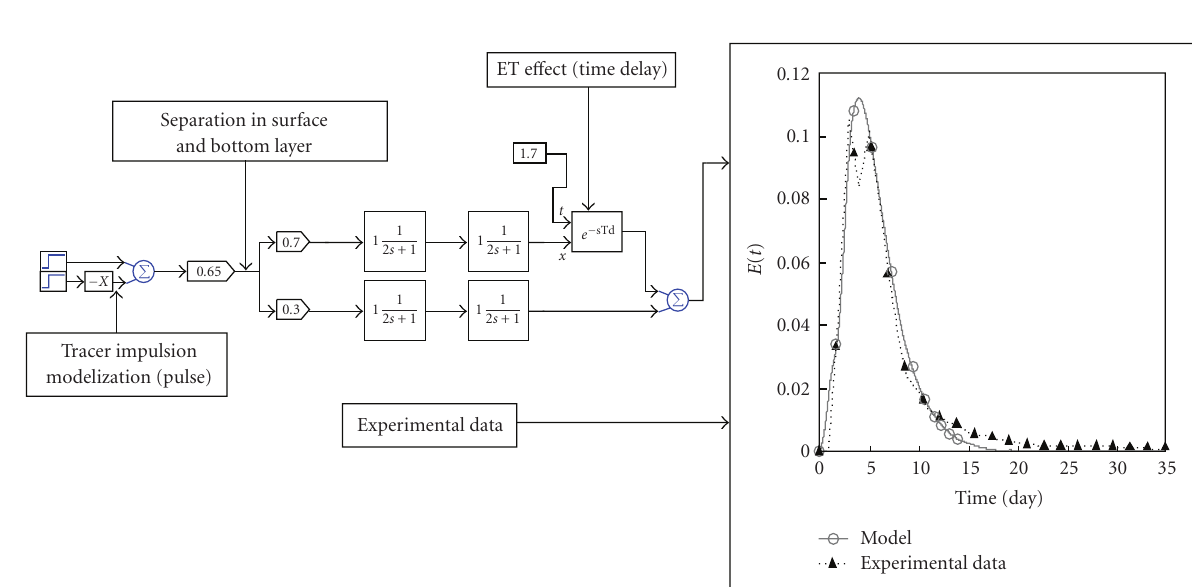
Figure 4: Conceptualized two-layer model (TLM) with results from